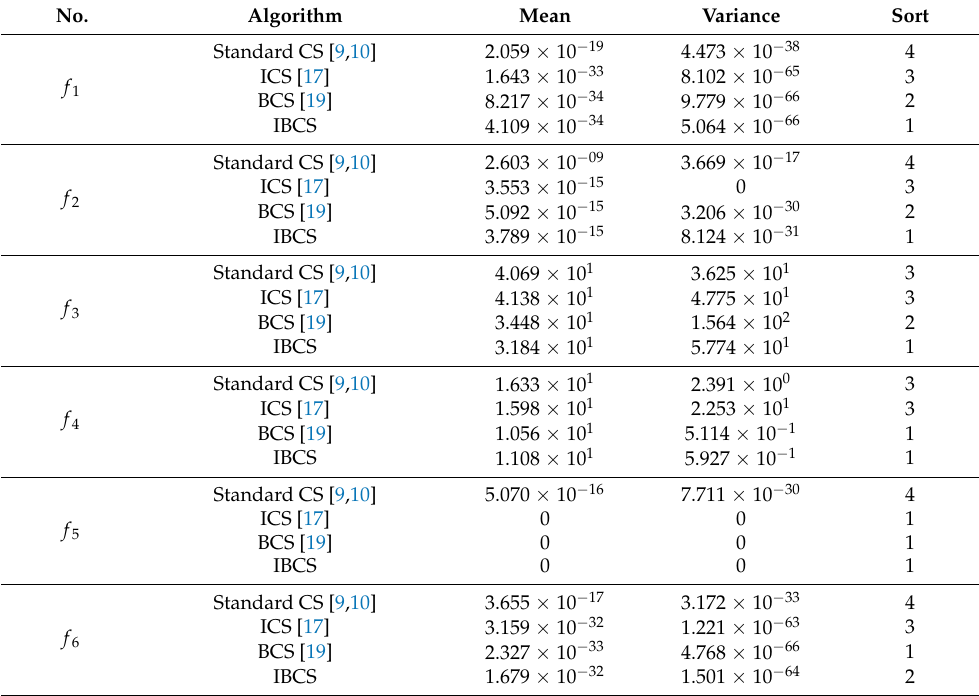
Table 2. Test results of four optimization algorithms on 30-dimensional test functions.